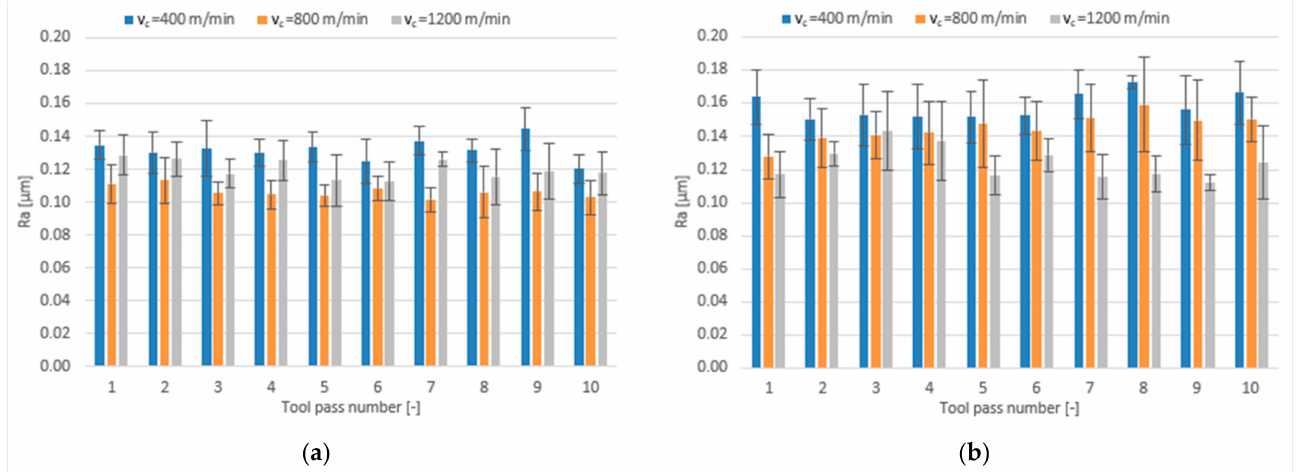
Figure 9. Cutting speed v c versus surface roughness parameter Ra in the milling process performed using a tool coated with: ( a ) TiB 2 and ( b ) TiAlN; (f z = 5 µ m/tooth; a p = 80 µ